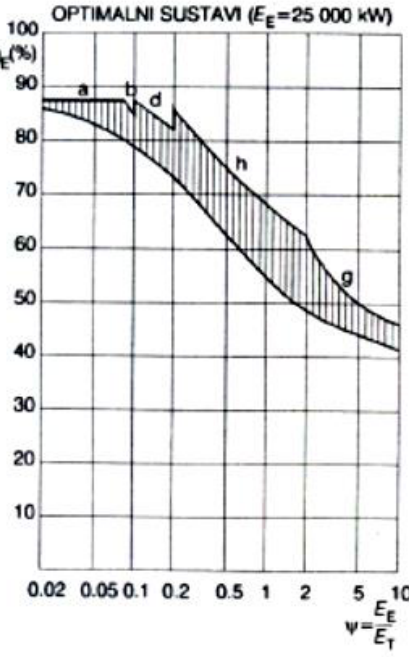
Fig. 6. Efficiency and power/heat ratio dependence diagram Source: (Kogeneracija,